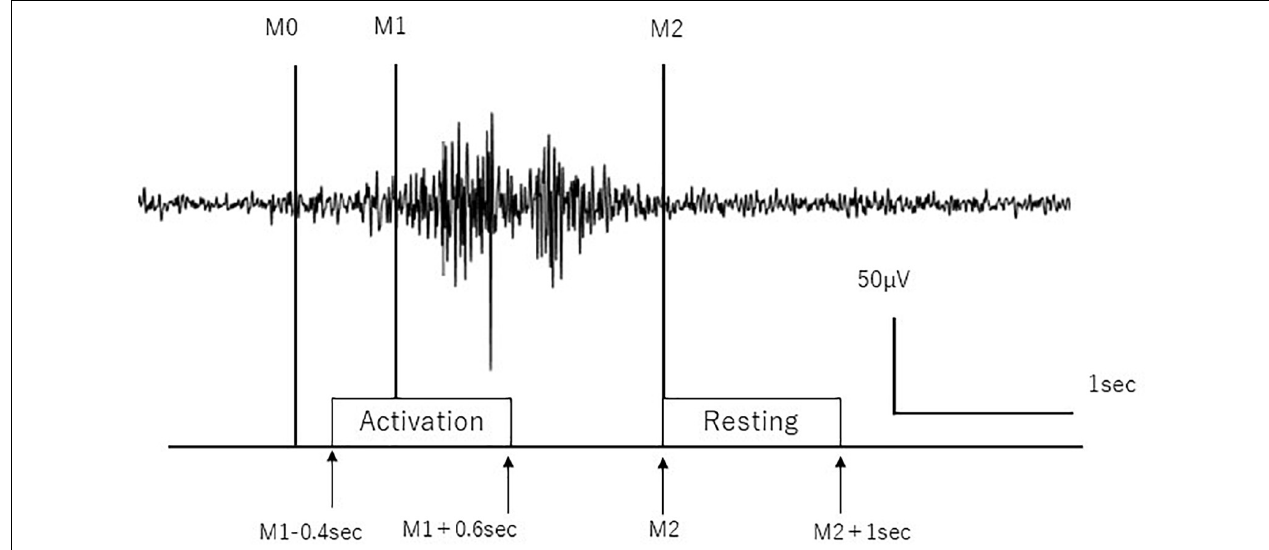
FIGURE 1 | Definition of activation and resting stages. Activation and resting stages are defined according to swallow-related submental group muscle activities. M0 is the time to initiate swallow, M1 is the time to start main muscle activation, and M2 is the time to return to baseline. The surface EMG trace during a single swallow is